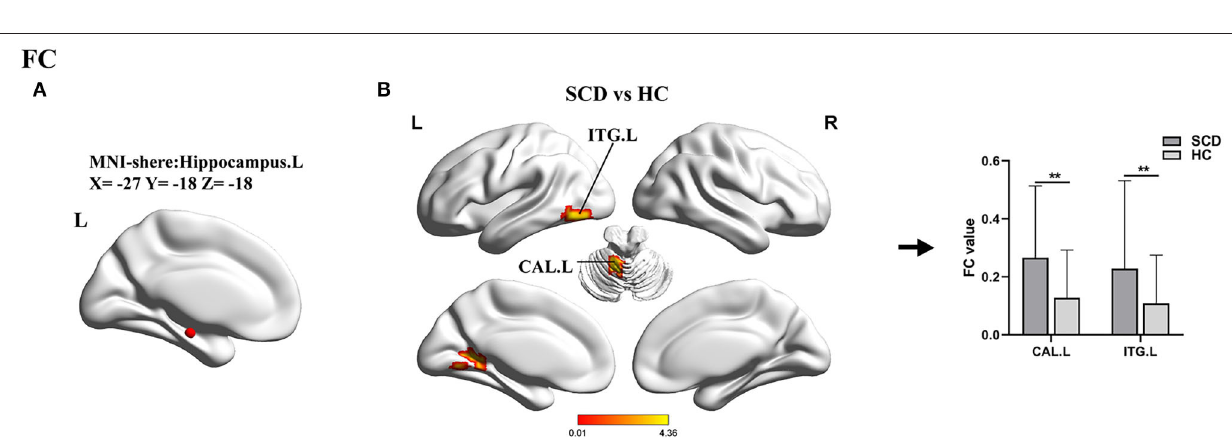
0.771 with p < 0.001. The AUC values of gFCD of the PHG.L and lrFCD of the PHG.L were 0.741 with p < 0.001 and 0.643 with p < 0.08. The AUC value of FC between the PHG.L and right calcarine was 0.635 with p < 0.012.